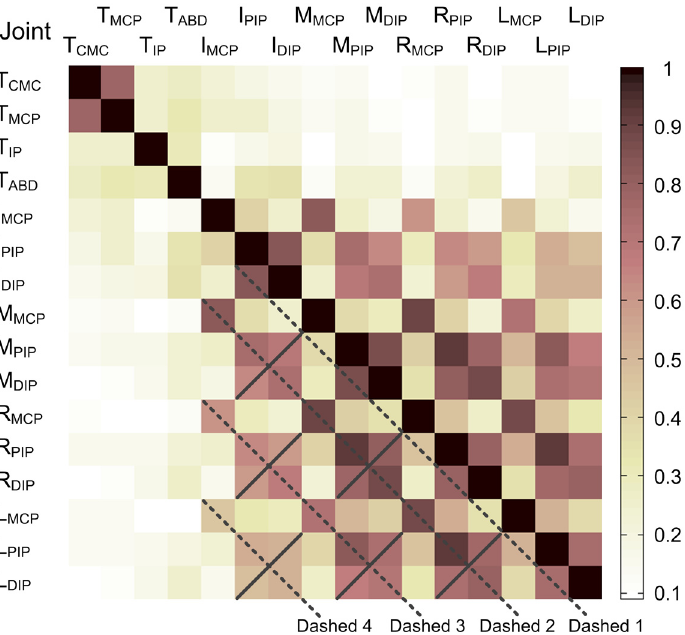
Fig 5. Graphic description of coordinated relationships for joint pairs. The value of coordination was averaged across subjects and is denoted by the grayscale with pink in each square. The pink color indicates the higher coordination for the corresponding joint pair. The diagram is axisymmetric. Dashed and solid lines passing through squares are used to describe different areas for joint pairs. The joints and abbreviated names are shown in Fig